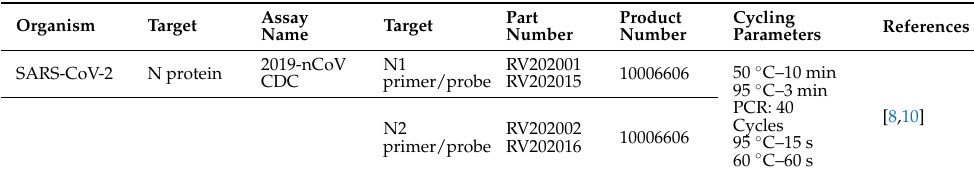
Table 1. Thermal cycling protocol and primers and probes used in the study.